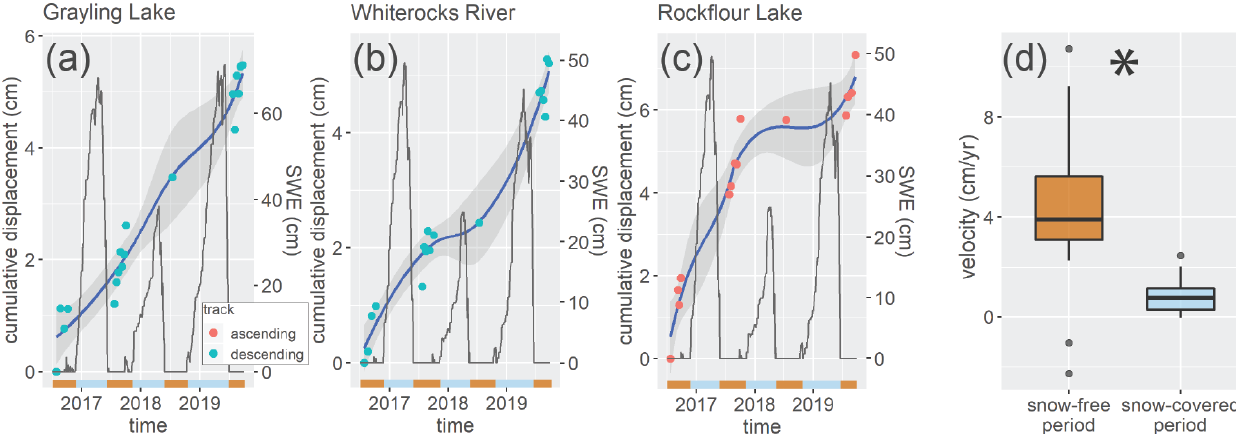
Figure 8. Displacement time series for three representative rock glaciers. (a–c) Time-dependent displacement of three rock glaciers from 2016 to 2019 and snow water equivalent (SWE) from nearby weather stations. Blue and orange bars along the x axes denote snow-free (orange) and snow-covered (blue) periods. Ascending and descending LOS are scaled so they are both positive and increasing. Time series displacement values were calculated using an average of 9 pixels (8100m 2 total area) in the rock glacier. Interferograms with low overall coherence were manually removed from the time series. Gray shaded regions around trend lines are 95% confidence intervals. (d) LOS velocities of three rock glaciers during the snow-free period in late summer compared to the snow-covered period from October to July; n = 30, and p = 0 . 001.